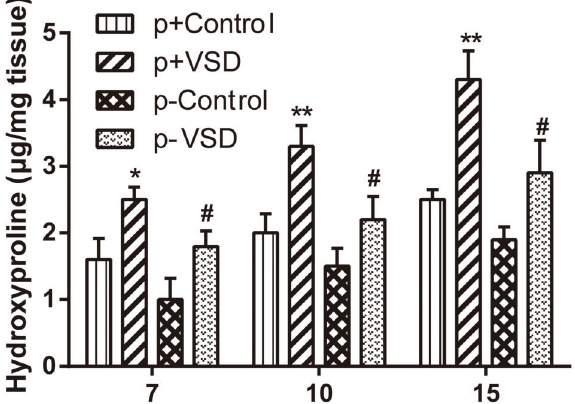
Figure 3. Quanti fi cation of hydroxyproline content during the course of wound healing, on post-operative days 7, 10, and 15. The vacuum sealing drainage (VSD)-treated groups had sig- ni fi cantly higher levels of hydroxyproline content than controls (traditional treatment). p + : periosteum-intact; p – : periosteum- lacking. Data are reported as means ± SD. *P o 0.05, **P o 0.01 compared to p + Control, # P o 0.05 compared to p – Control.